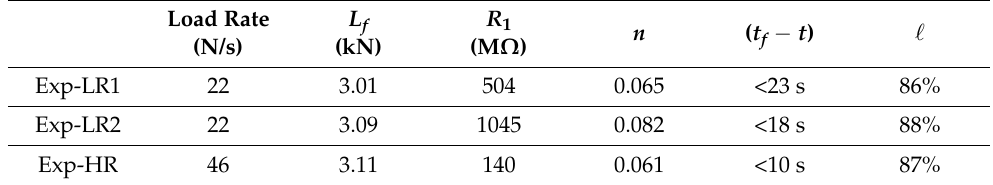
(cid:16) (cid:17) (cid:16) (cid:17) m = A · t f − τ t f − τ , for the presented